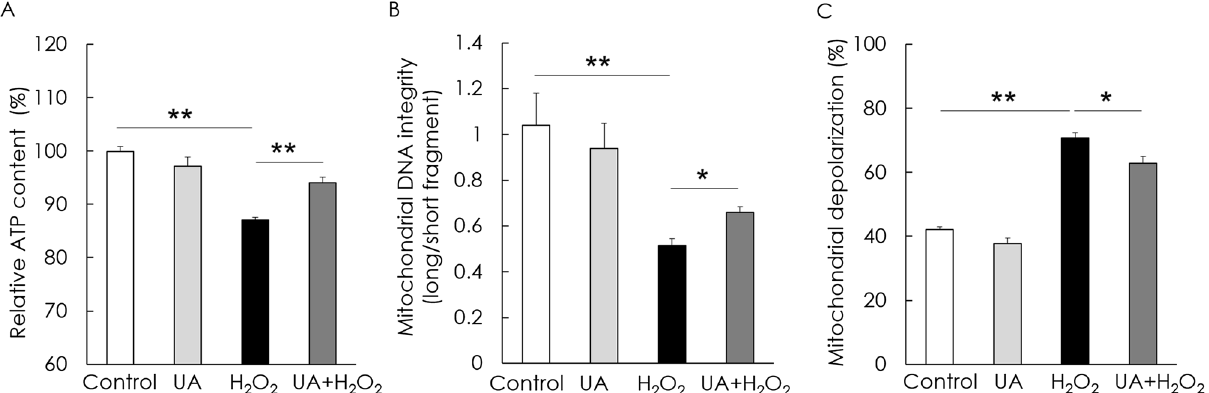
Figure 6. Effect of UA on ATP content, mitochondrial DNA (mtDNA) integrity, and mitochondrial depolarization in H 2 O 2 -induced senescent HEI-OC1 cells. ATP content was significantly preserved in H 2 O 2 - treated cells upon UA pre-treatment ( A ). The mtDNA integrity in the UA pre-treatment group was